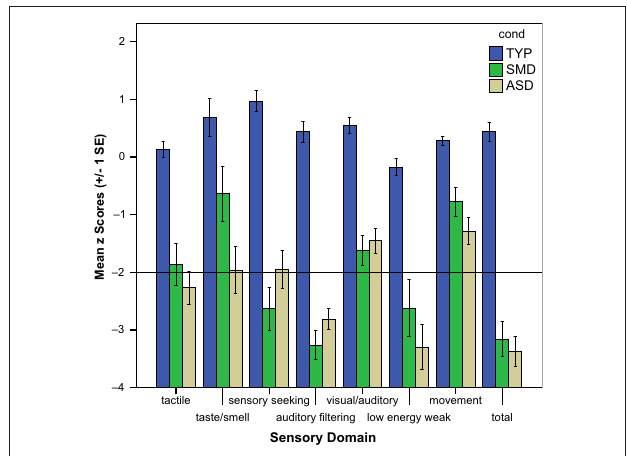
FIGURE 3 | Classifi cation of sensory-related behaviors in ASD and